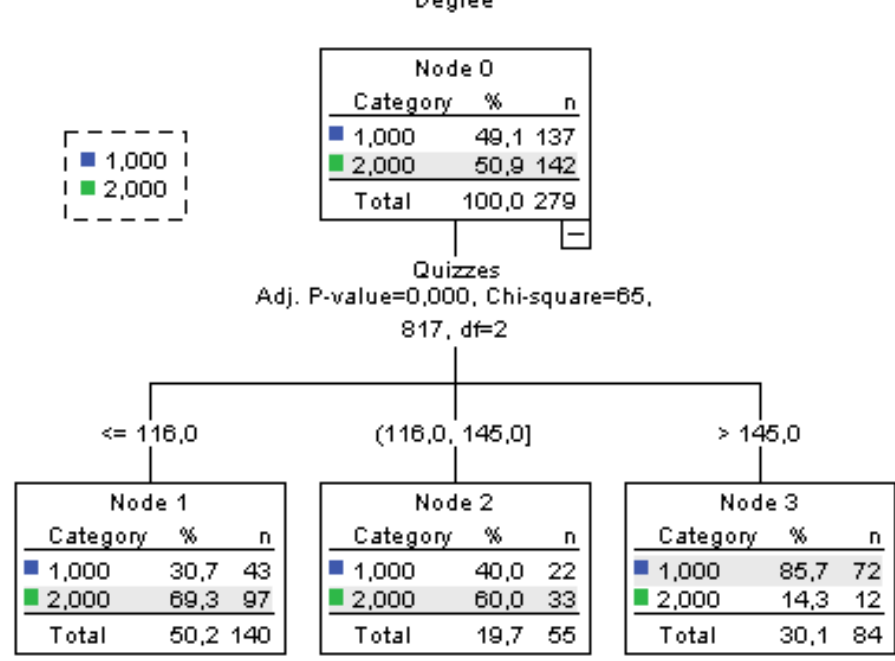
Figure 8. Decision tree. Note. 1 = nursing students; 2 = occupational therapy students. Table 3. Centres of final clusters for the learning results variable in blended learning type 1 and type 2.